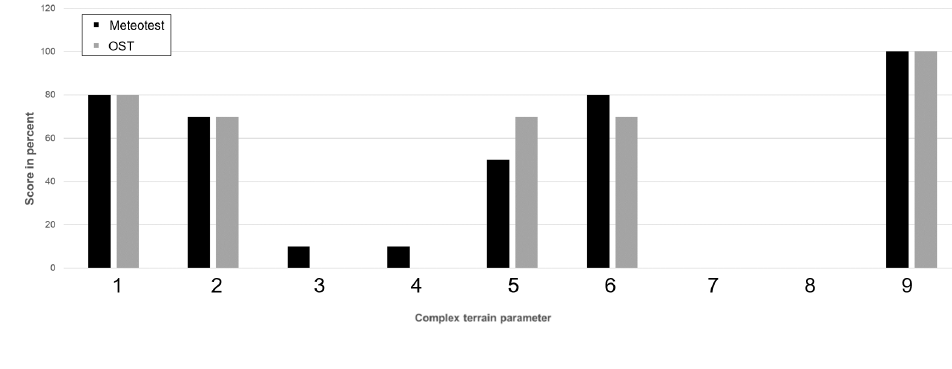
Figure A8. Answers to the ten complex terrain questions for Site